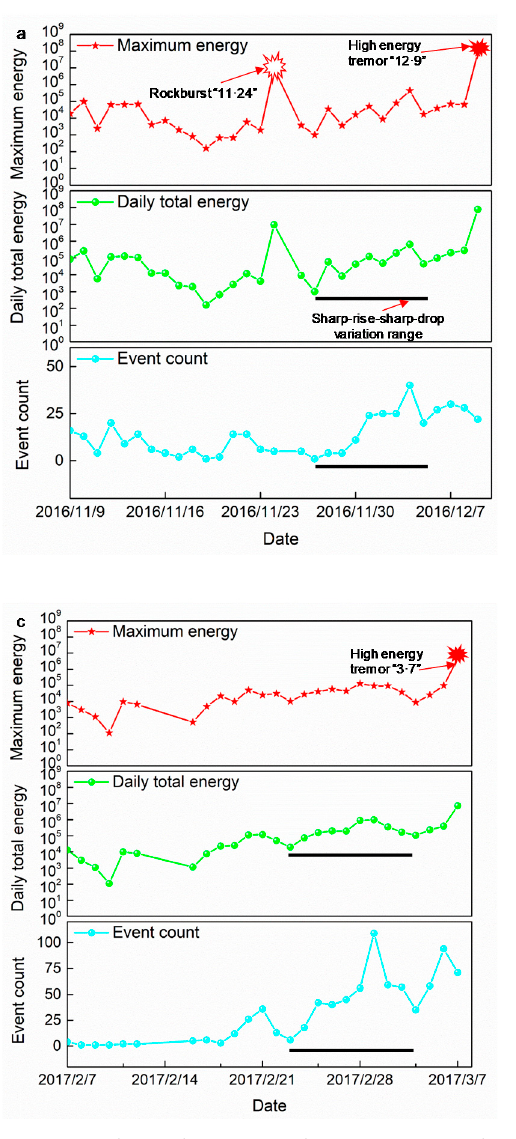
Figure 7. Daily total energy and event count evolution law before one month the high energy tremors. ( a ) “12 · 9”, ( b ) “12 · 23”, ( c ) “3 · 7”, ( d ) “3 · 21”.